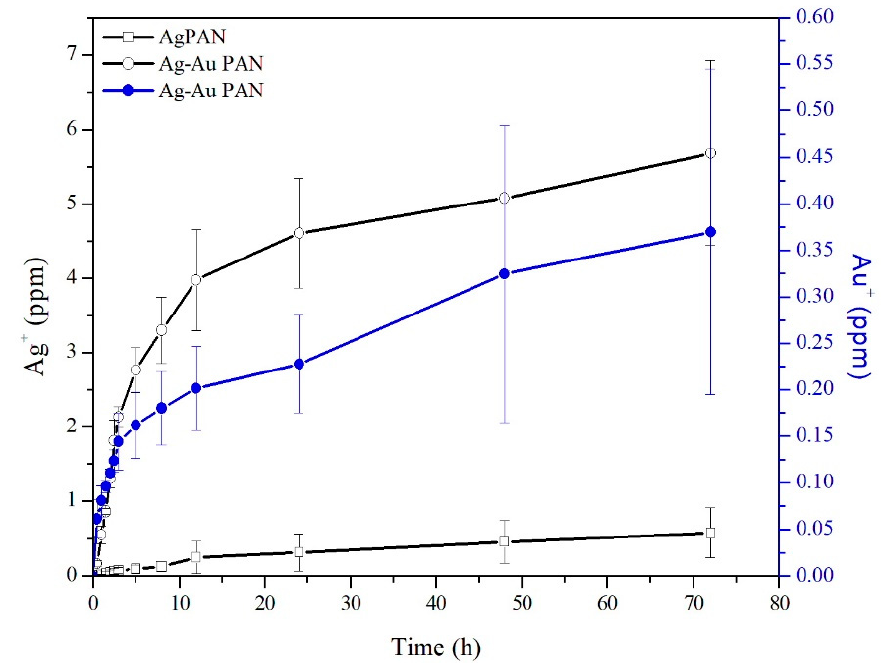
Figure 3. Profile of silver ion release curve.